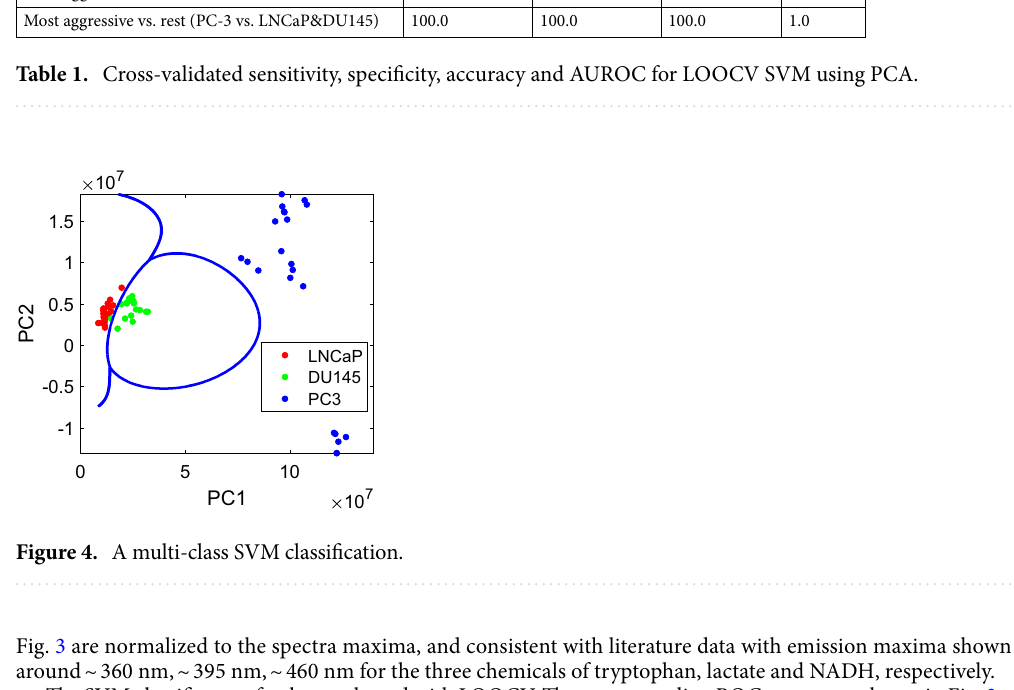
(PCA) Classifiers